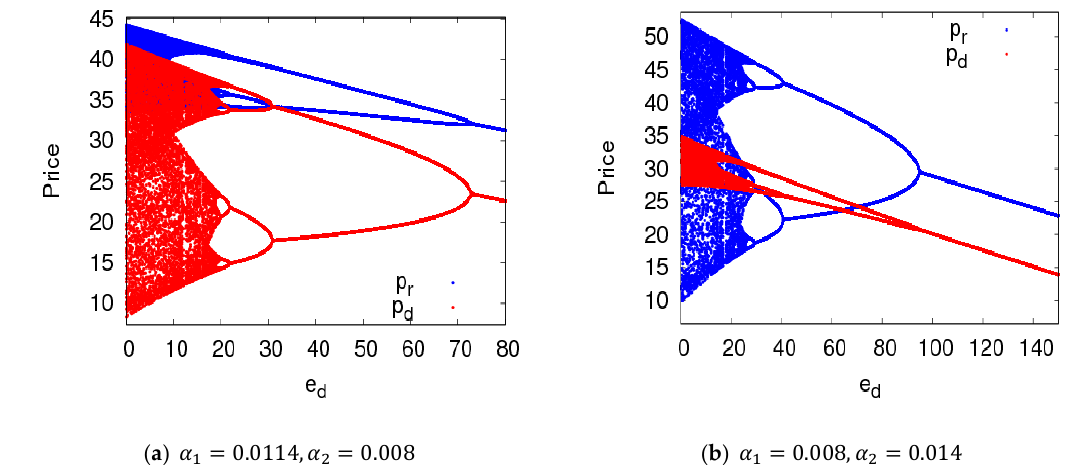
Figure 11. The evolution characteristics of dynamic System (7) with an increasing 𝑒 𝑑 .